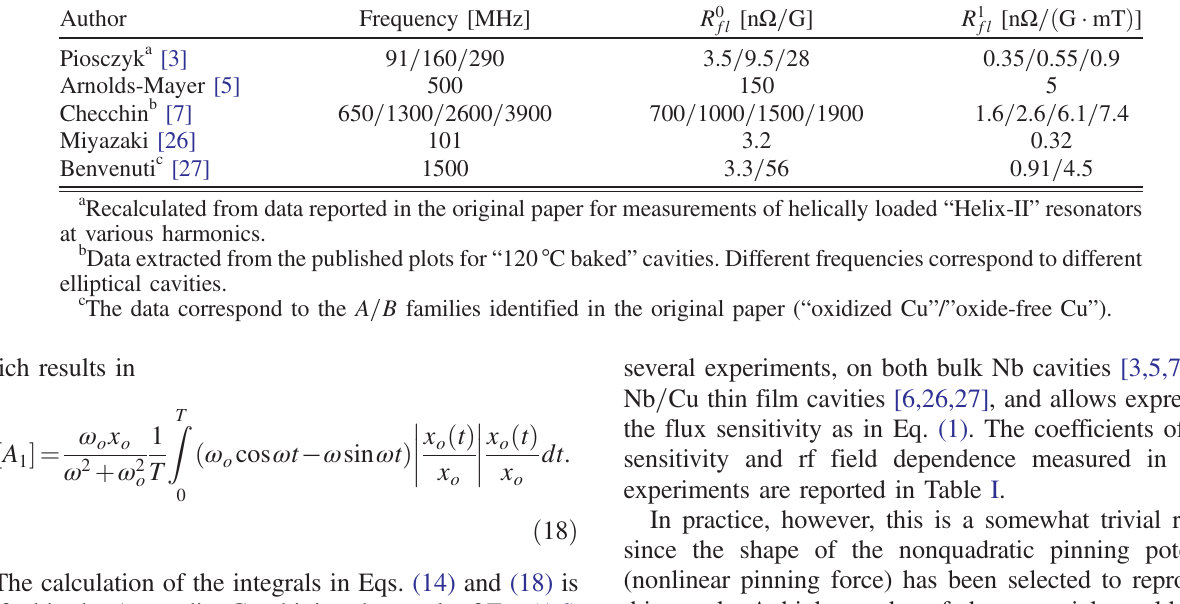
and R 1 as measured by several authors. The first lines are for bulk Nb, while the fl fl